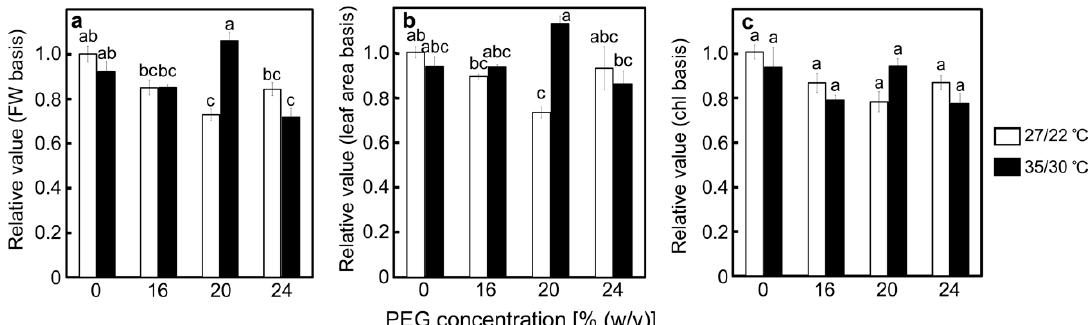
Figure 7. The relative amount of cytochrome f after drought stress treatment on a leaf fresh weight basis ( a ), leaf area basis ( b ), and unit chlorophyll content basis ( c ) under two di ff erent temperature conditions in rice. Approximately 60 days after germination, hydroponically grown plants were drought-stressed using culture solutions containing PEG at 0, 16, 20, 24% ( w / v ) for two days under an irradiance of 450 µ mol photon m − 2 s − 1 and day / night air temperatures of 27 / 22 ◦ C or 35 / 30 ◦ C, followed by western blotting using polyclonal-monospecific antibodies against cytochrome f . Data of the PEG-untreated control plants were defined as 1. Data are presented as means ± SE ( n = 3). Statistical analysis was carried out by ANOVA, followed by Turkey–Kramer’s test. Columns with the same letter were not significantly di ff erent ( p < 0.05).